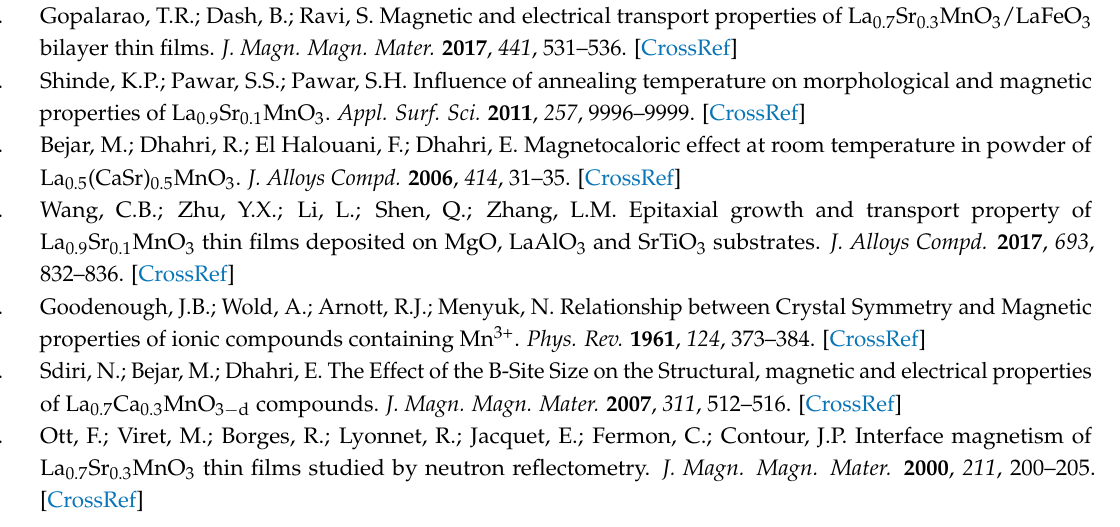
s1, Figure S1: HRTEM image of the LSMO_F film imaged in [001] zone axis with FFTs corresponding to different parts of the film, Figure S2: Dependence of Goldschmidt’s tolerance factor for the different types of fluorination reactions under neglectance of ordering effects for anion deficient